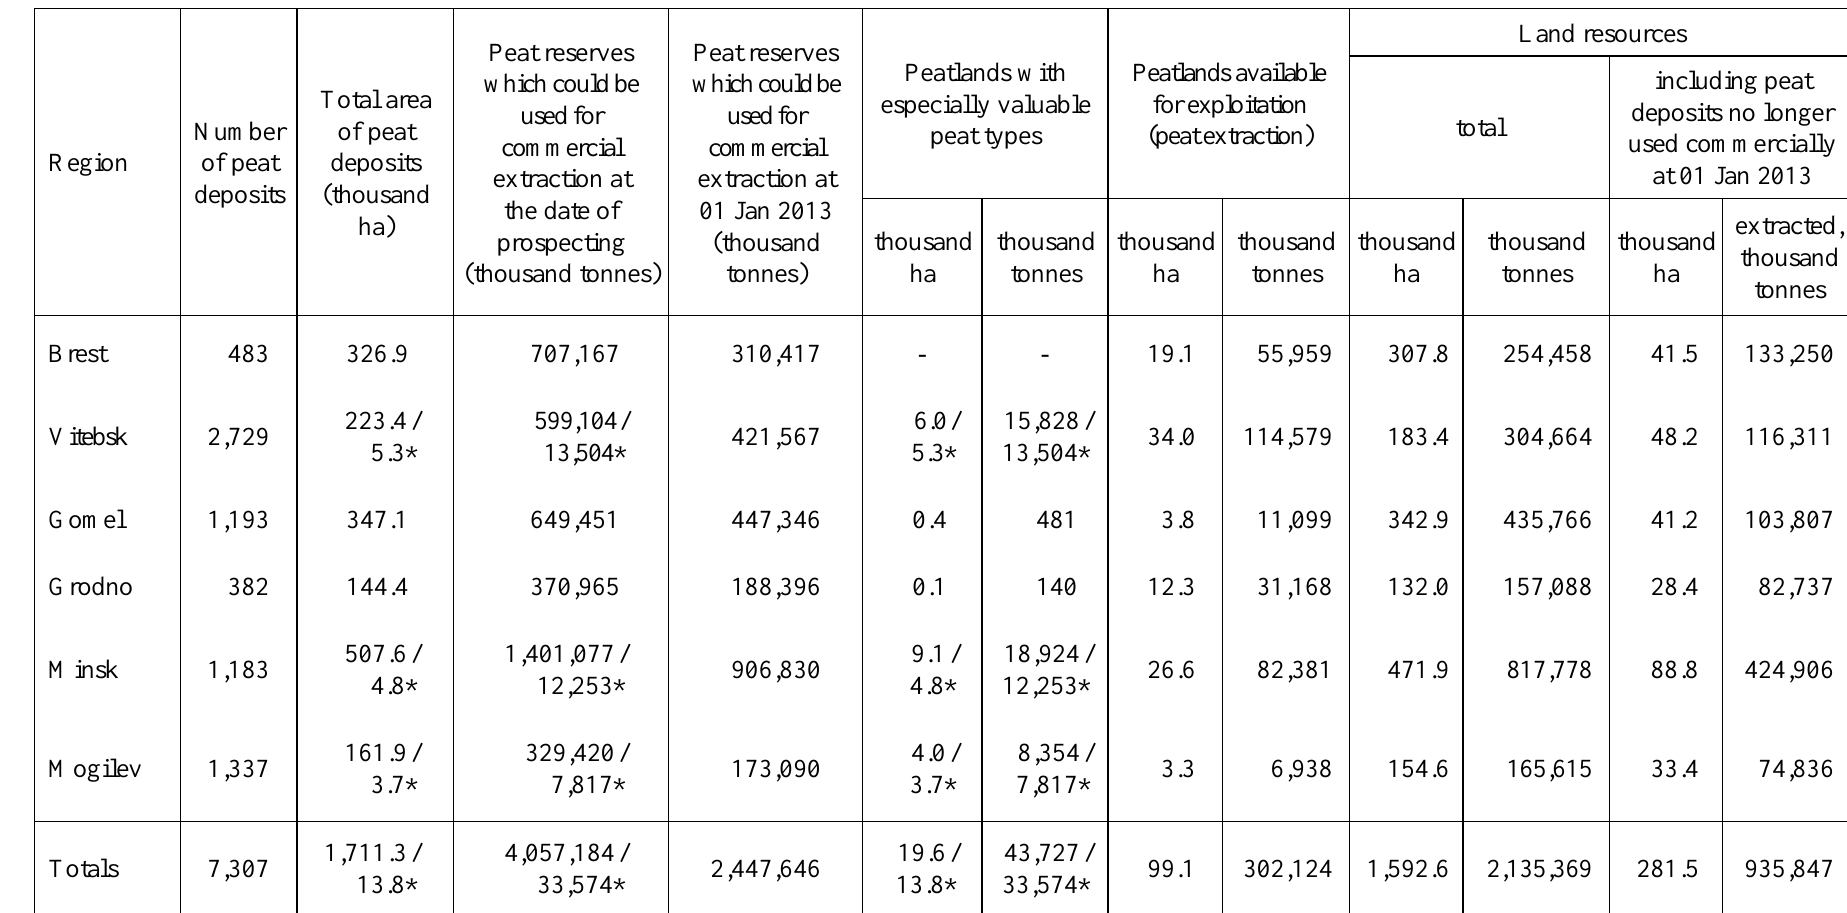
Table A2.3. Reserves of peatlands with especially valuable peat types, for exploitation (peat extraction), and as land resources (breakdown per region).